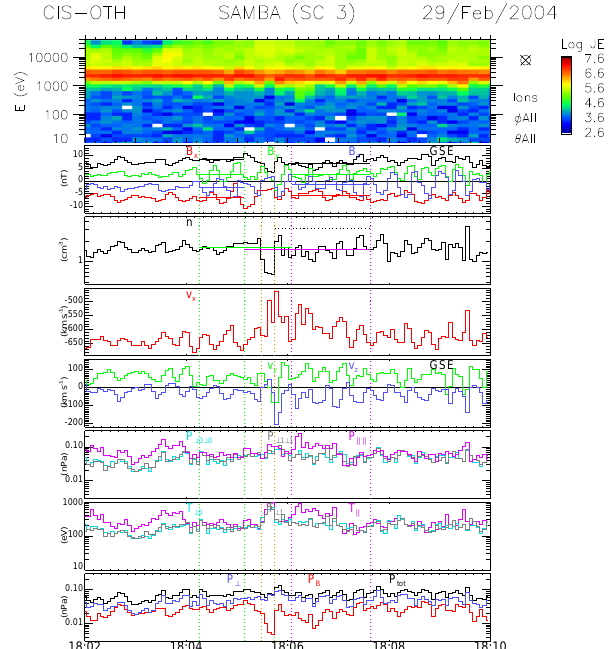
Fig.10. Fig. 10. 29 February 2004 18:02–18:10UT summary plot. HIA ion energy spectrogram, B , and various HIA moments. Representative selection intervals indicated (see text for